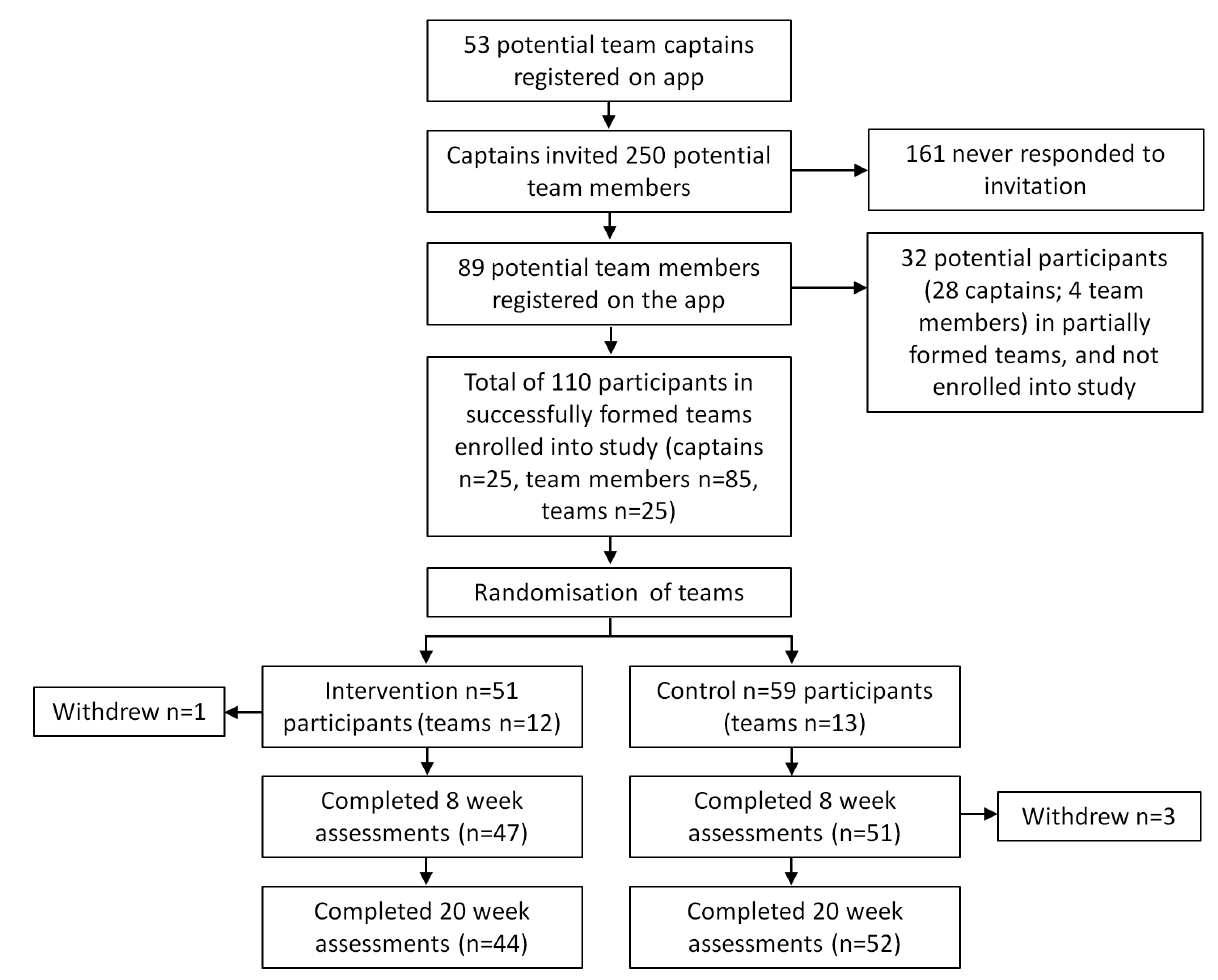
Figure 3. Overview of participant recruitment, assessment, and